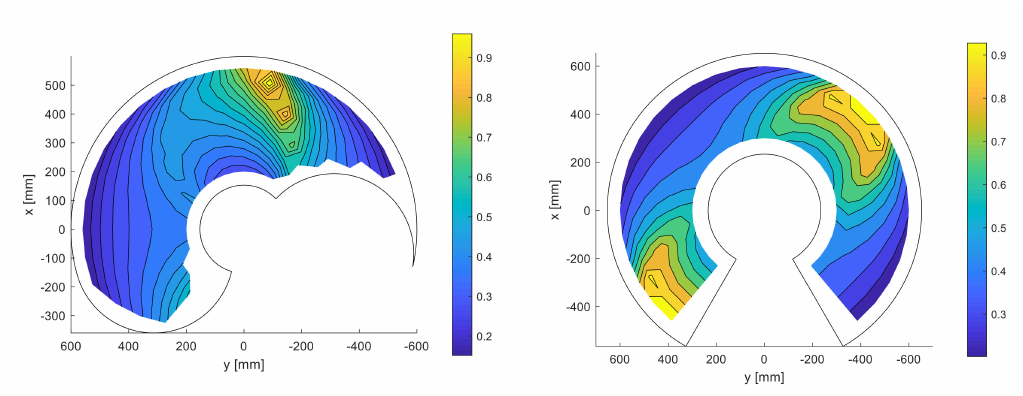
Figure 7. KDI computed for SCARA ( left ) and articulated ( right )